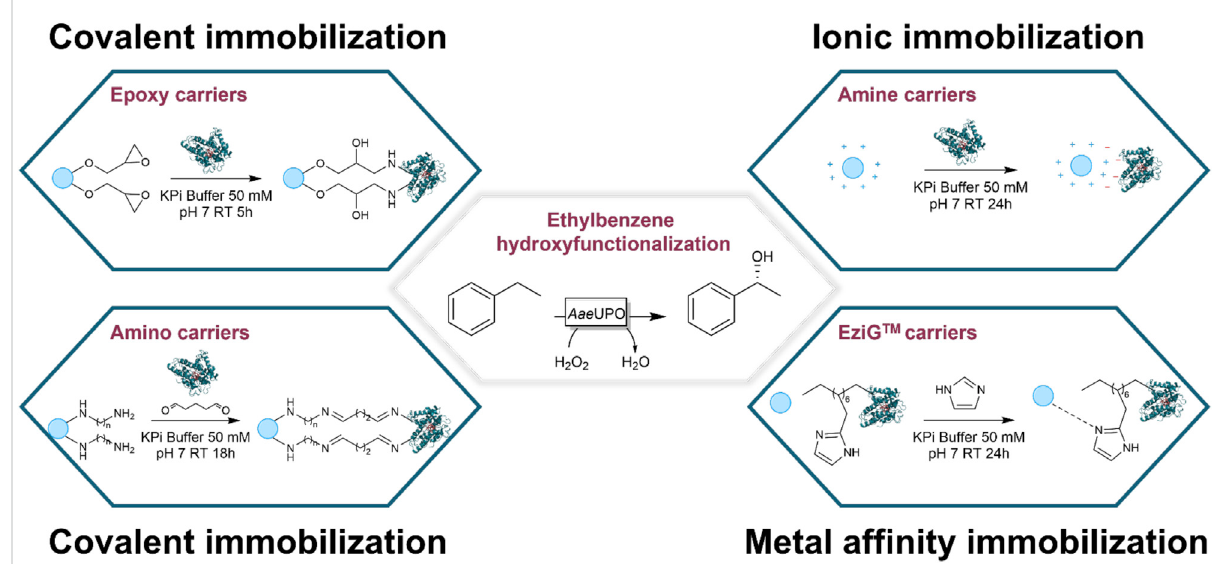
FIGURE 1 Schematic representation of the covalent, ionic, and metal af fi nity-binding immobilization techniques investigated in this study. The ethylbenzene hydroxy functionalization to ( R )-1-phenylethanol is the model reaction chosen as proof-of-concept of immobilized enzyme